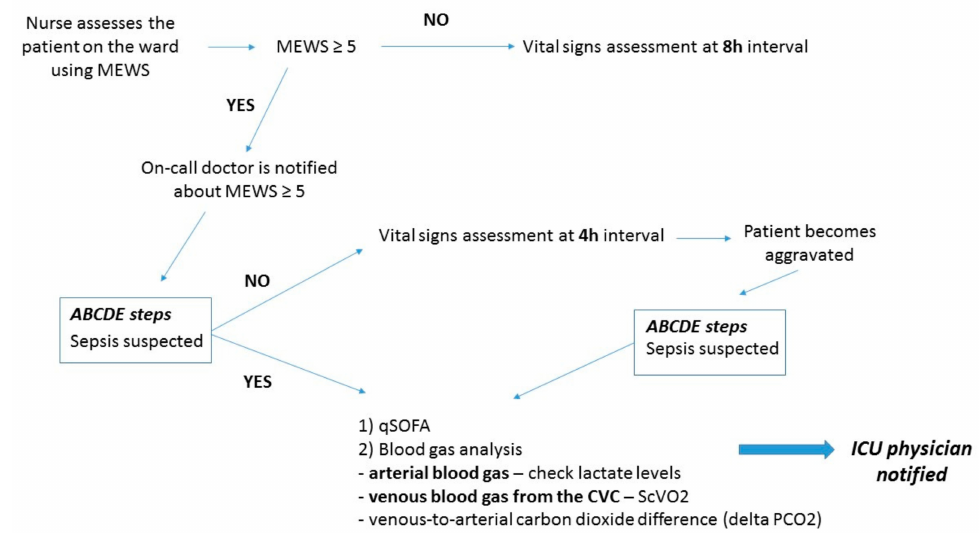
Figure 3. Clinical approach to the critical patient on the